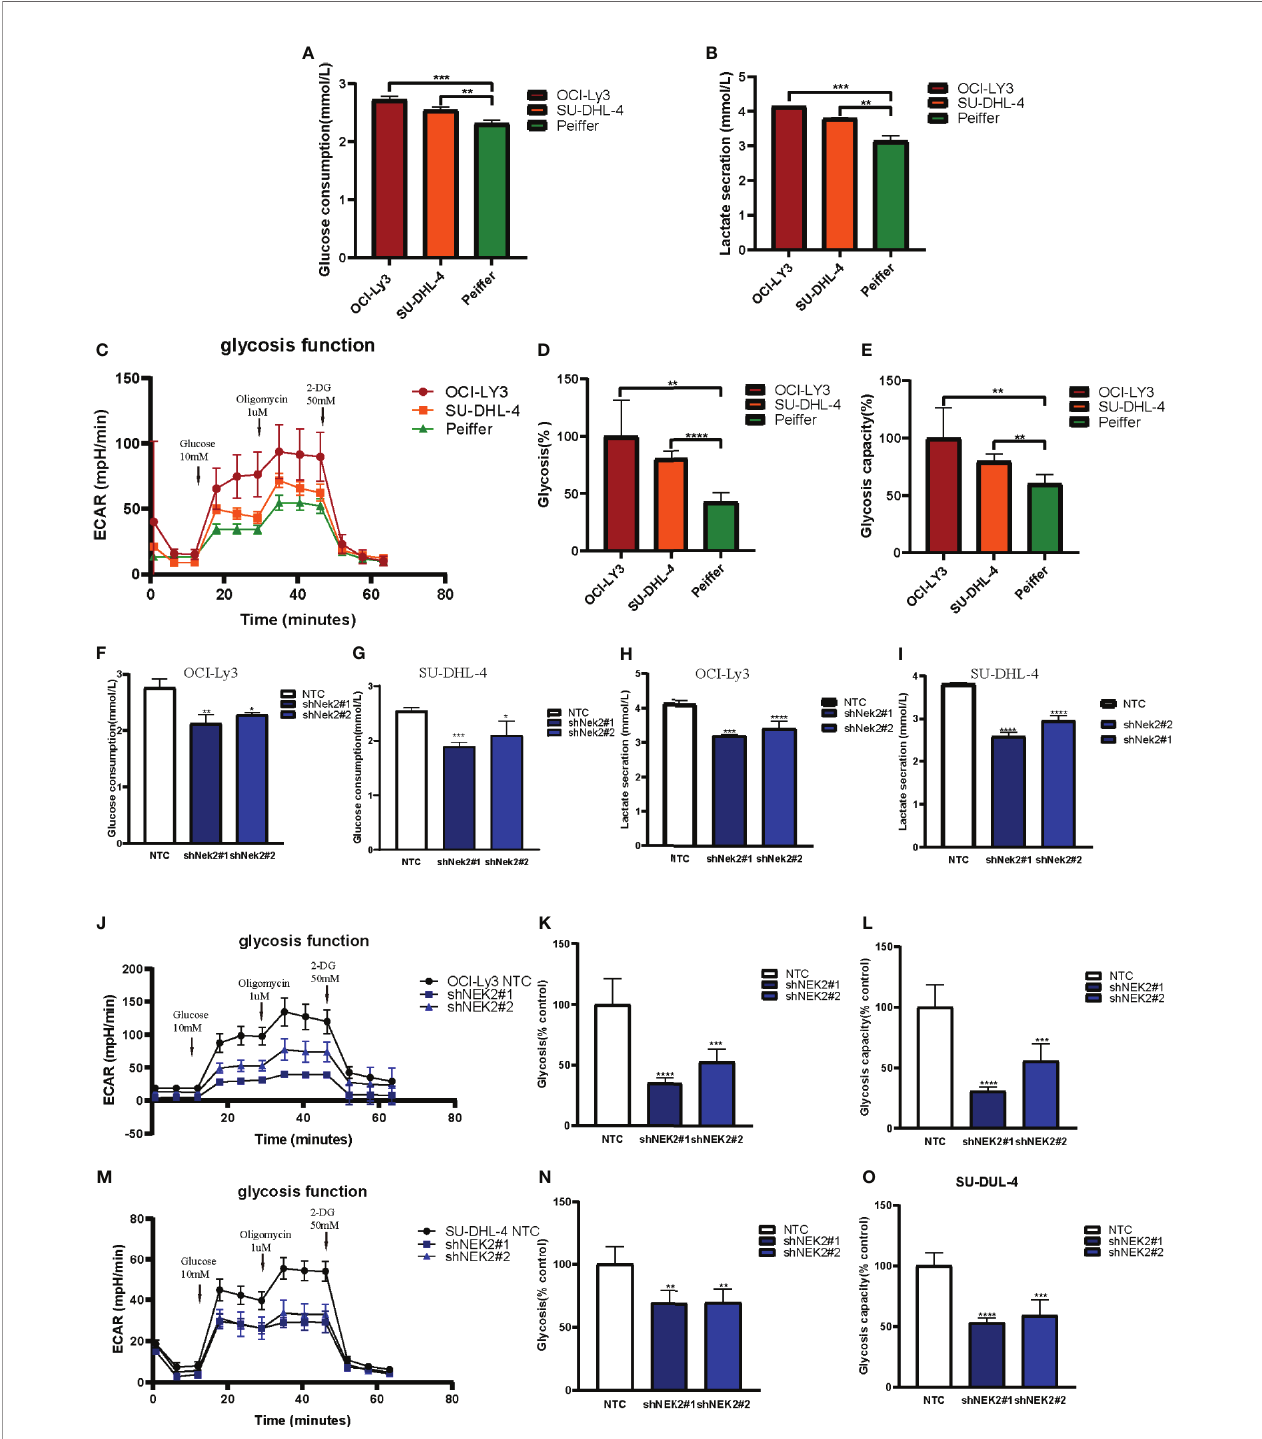
FIGURE 3 | NEK2 promoted aerobic glycolysis in DLBCL cells. (A, B) Glucose uptake and lactate production were analyzed in OCI-Ly3, SU-DHL-4 cells, and Peiffer cells cultured at normoxia (**P < 0.01, ***P < 0.001, Student ’ s t-test); (C) Representative image of ECAR measurement in OCI-Ly3, SU-DHL-4 cells, and Peiffer cells; (D – E) OCI-Ly3 and SU-DHL-4 had higher glycolytic rate and more robust glycolytic capacity compared with Peiffer (**P < 0.01, ****P < 0.0001, Student ’ s t-test); (F – I) Glucose uptake and lactate production were analyzed in NEK2 silencing and control cells of OCI-Ly3 and SU-DHL-4 cultured at normoxia; (*P < 0.05, **P < 0.01, ***P < 0.001, ****P < 0.0001, Student ’ s t-test) (J, M) Representative image of ECAR measurement in NEK2 silencing and control cells of OCI-Ly3 and SU- DHL-4; (K, L, N, O) Knockdown of NEK2 decreased glycolysis and glycolytic capacity of DLBCL cells (**P < 0.01, ***P < 0.001, ****P < 0.0001, Student ’ s